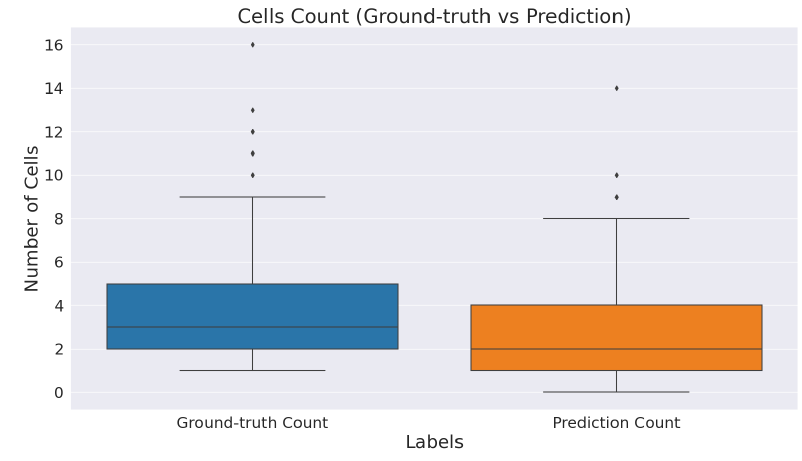
Figure 6. Boxplot of total cell identified by ICOSeg compared to actual cells of the ground-truth.